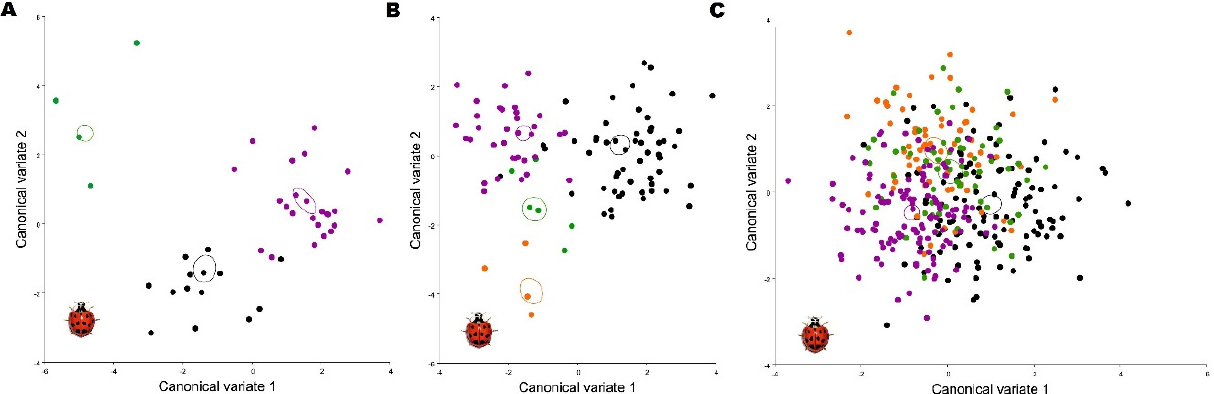
Figure 5. Canonical variate analysis of the different populations by form in H. axyridis : ( A ) conspicua form; ( B ) spectabilis form; ( C ) succinea form. The colors represent the different populations: green, Osijek; purple, Sveti Ivan Zelina; black, Garešnica; orange, Ludbreg.